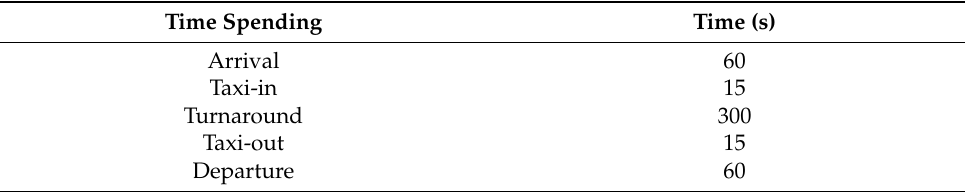
Table 5. Segment time spending (one TLOF pad, four